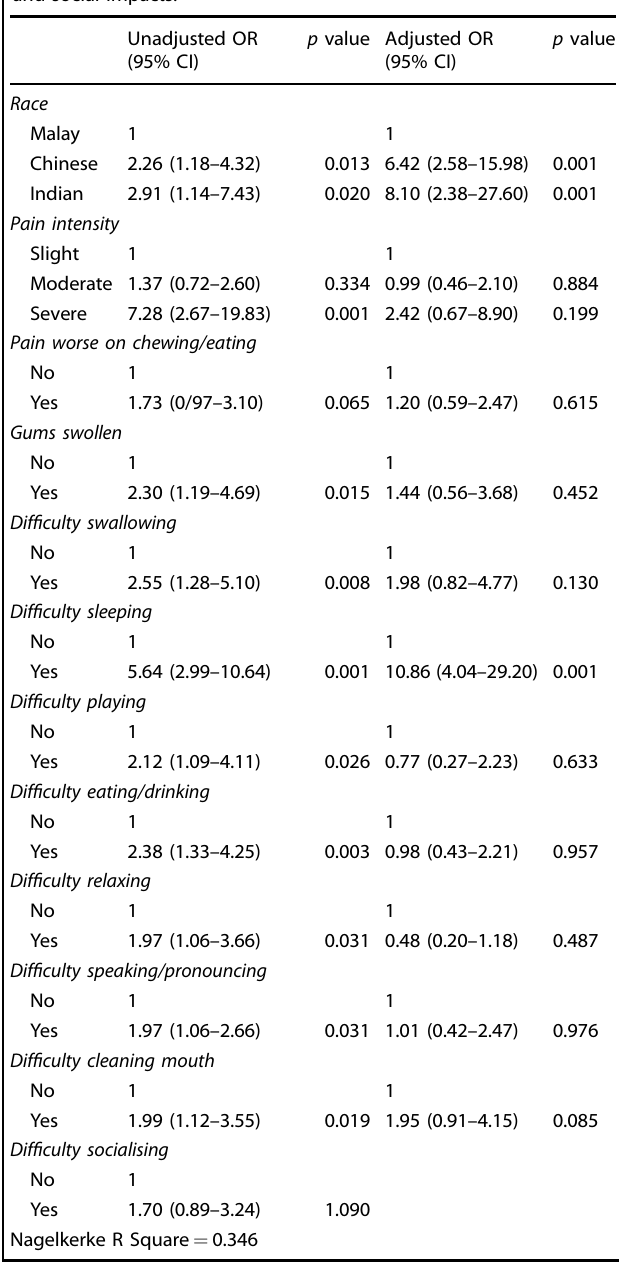
Table 6. Unadjusted and Adjusted Odds Ratios (ORs) with 95% Con fi dence Intervals (95% CIs) for the association between visiting a dentist for tooth pain in the past 1 month and race, pain symptoms and social